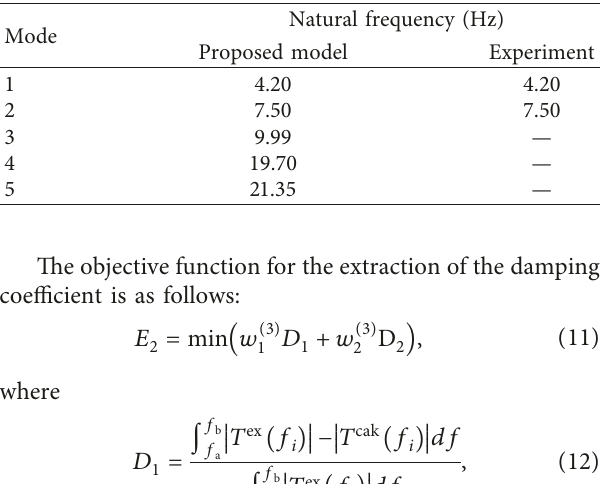
Table 2: Natural frequencies of the proposed human model and